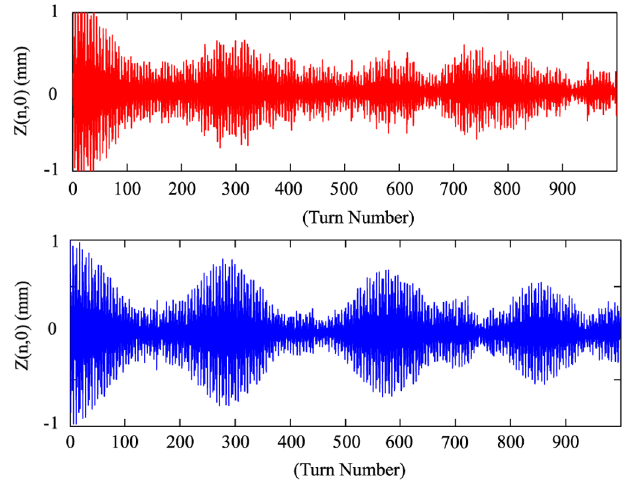
FIG. 8. (Color) Plot of measured and simulated Z (cid:3) n; (cid:1) (cid:4) versus n FIG. 10. (Color) Plot of measured and simulated Z (cid:3) n; (cid:1) (cid:4) versus n turns. Shown is the transverse (horizontal) turn-by-turn data of turns. Shown is the transverse (horizontal) turn-by-turn data of (cid:5) head after a 1 mm kick 4 nsecs ahead of bucket center ( (cid:1) center ( (cid:1) (cid:5) 0 nsecs ) after a 1 mm kick. Actual turn-by-turn data 0 (top) compared with 1000 particle simulation with resistive wall 4 nsecs ). Actual turn-by-turn data (top) compared with 1000 (cid:5) 12 cm 1 : 5 and (cid:5) 12 cm 1 : 5 and chromaticity (cid:4) (cid:5) 3 : 733 and (cid:8) particle simulation with resistive wall wake W wake W 1 ? 1 ? (cid:5) 3 nsecs . chromaticity (cid:4) (cid:5) 3 : 733 and (cid:8) 3 nsecs (cid:1)